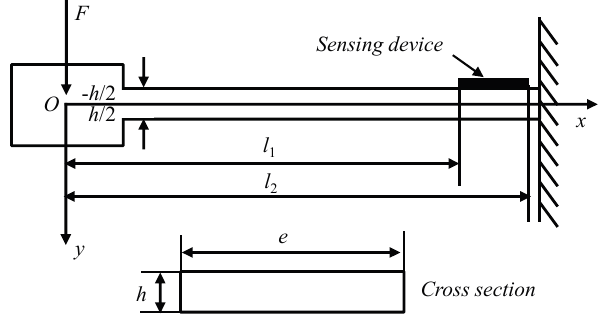
Figure 2. The static model of the vibration sensor with cantilever